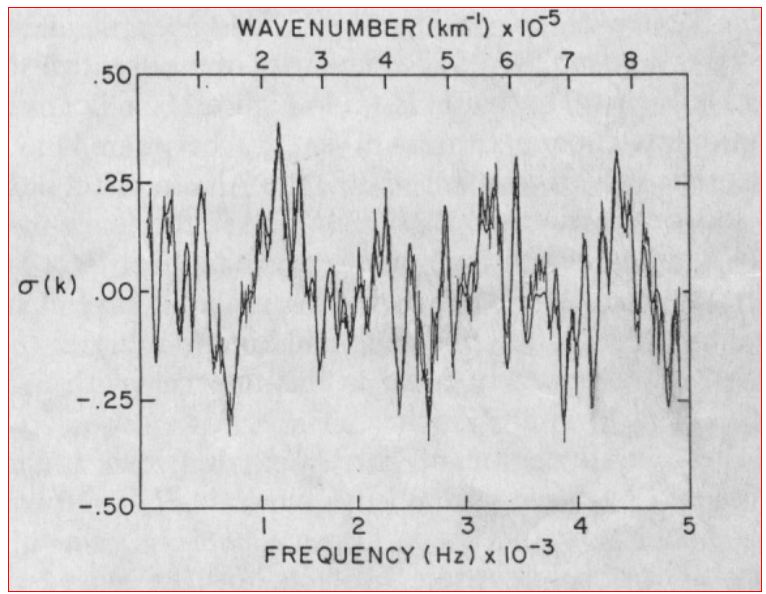
Figure 34: 𝜎 m vs. frequency and wave number relative to an interplanetary data sample recorded by Voyager 1 at approximately 1 AU. Image reproduced by permission from Matthaeus and Goldstein (1982b), copyright by